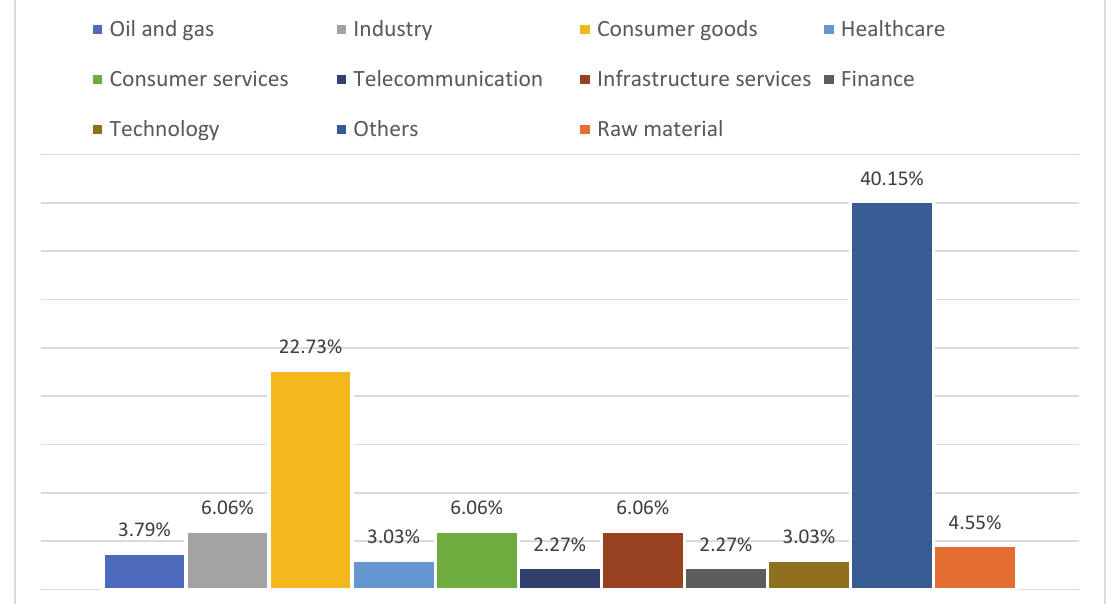
Fig. 2. Structure by business activities of the